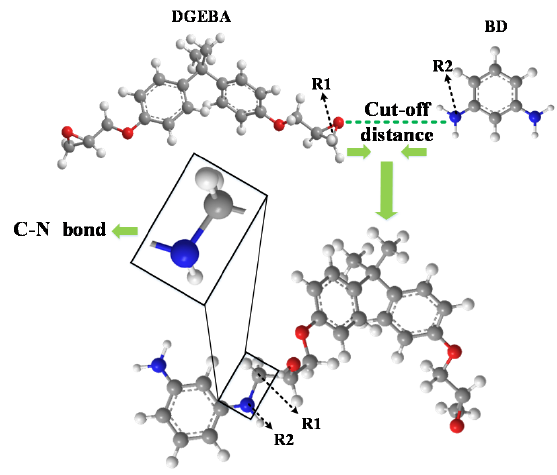
Figure 1. Schematic diagram of epoxy resin cross-linked reaction.